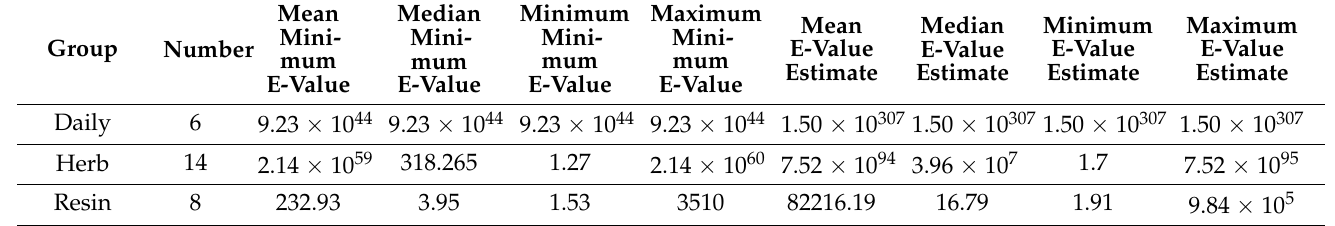
Table 12. Summary of E-Values by